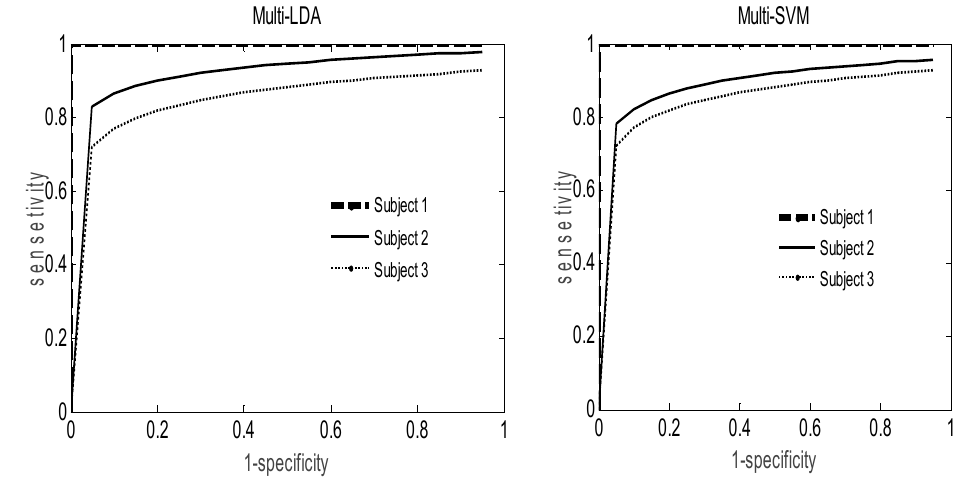
Figure 5. ROC curve analysis for the proposed classifiers.